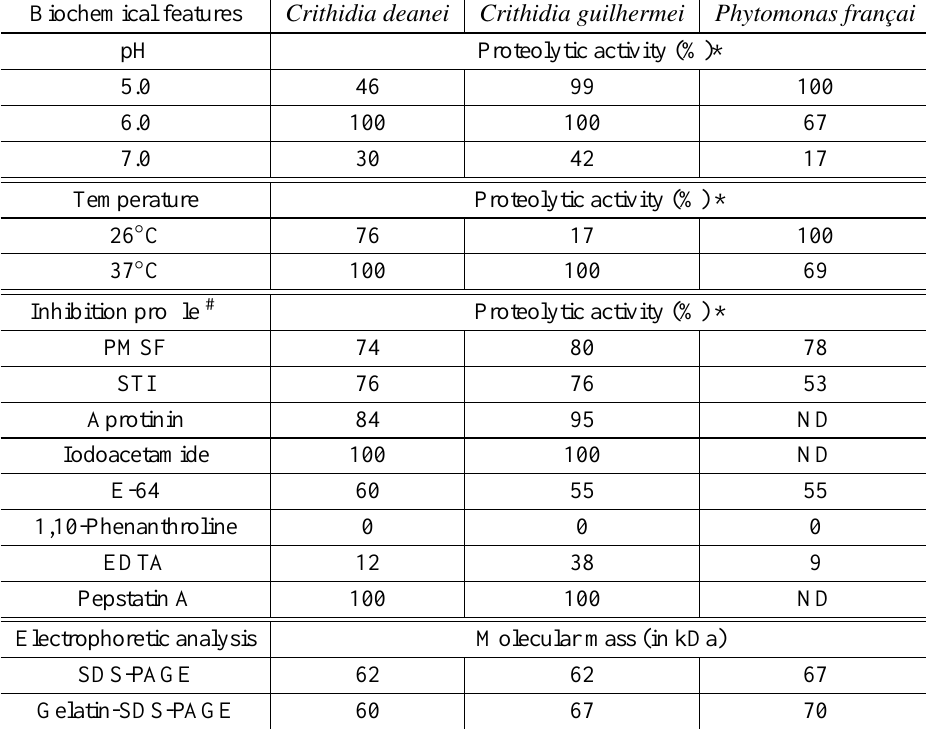
Biochemical features displayed by the released metalloproteases purified and characterized from Crithidia deanei (cured strain) (d’Avila-Levy et al. 2003), Crithidia guilhermei (Nogueira de Melo et al. 2002) and Phytomonas françai (Almeida et al. 2003). Biochemical